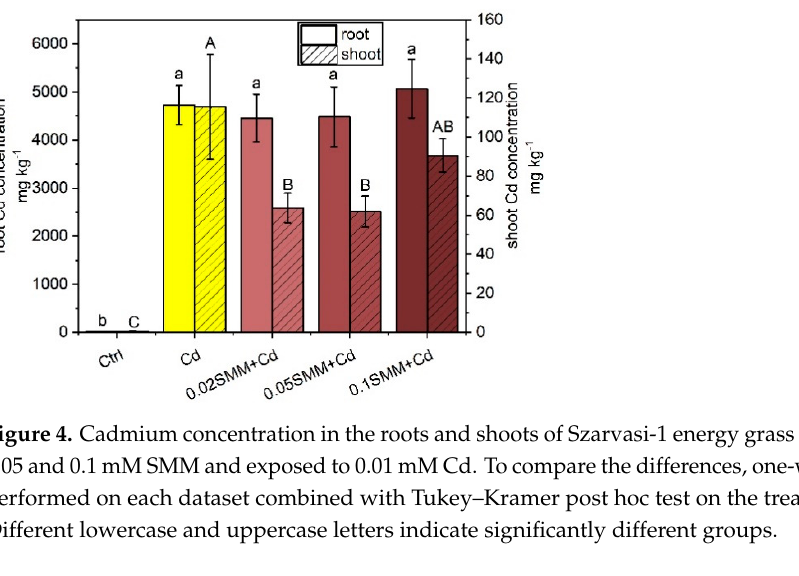
centers (F v /F m ) ( B ) and MDA concentration ( C ) in the youngest fully developed leaves of Szarvasi-1